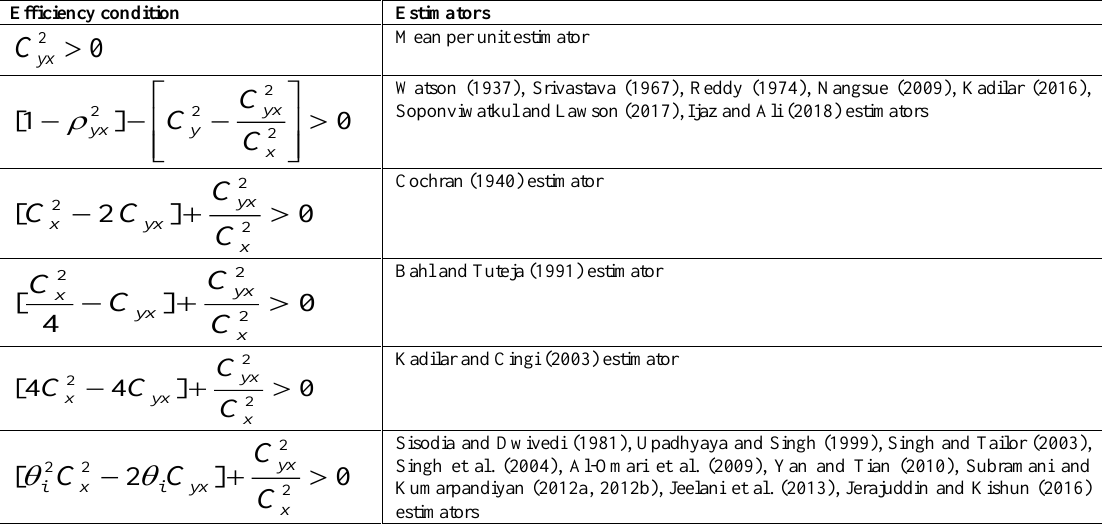
Table 3. Conditions under which proposed estimators are better than existing